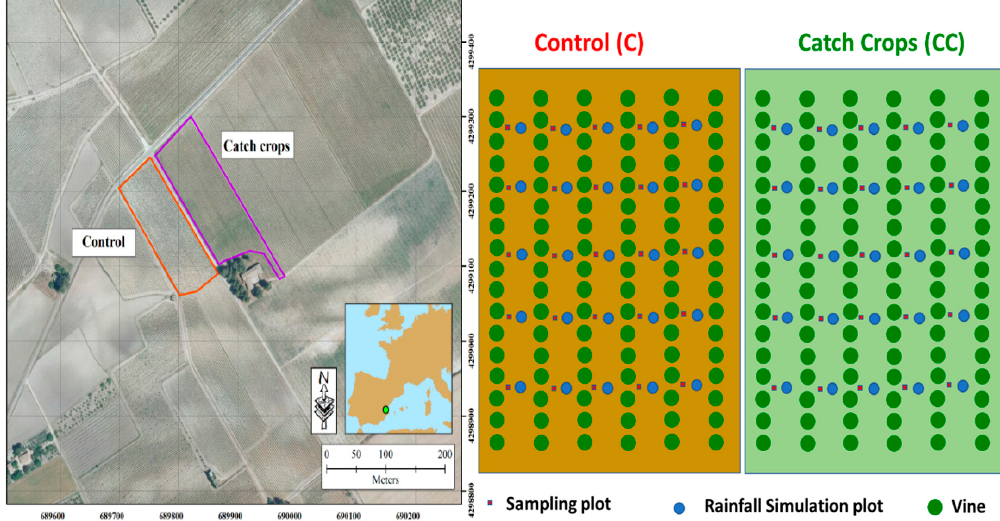
Figure 1. Study area location to the left and the sampling layout to the right for the control and catch crops